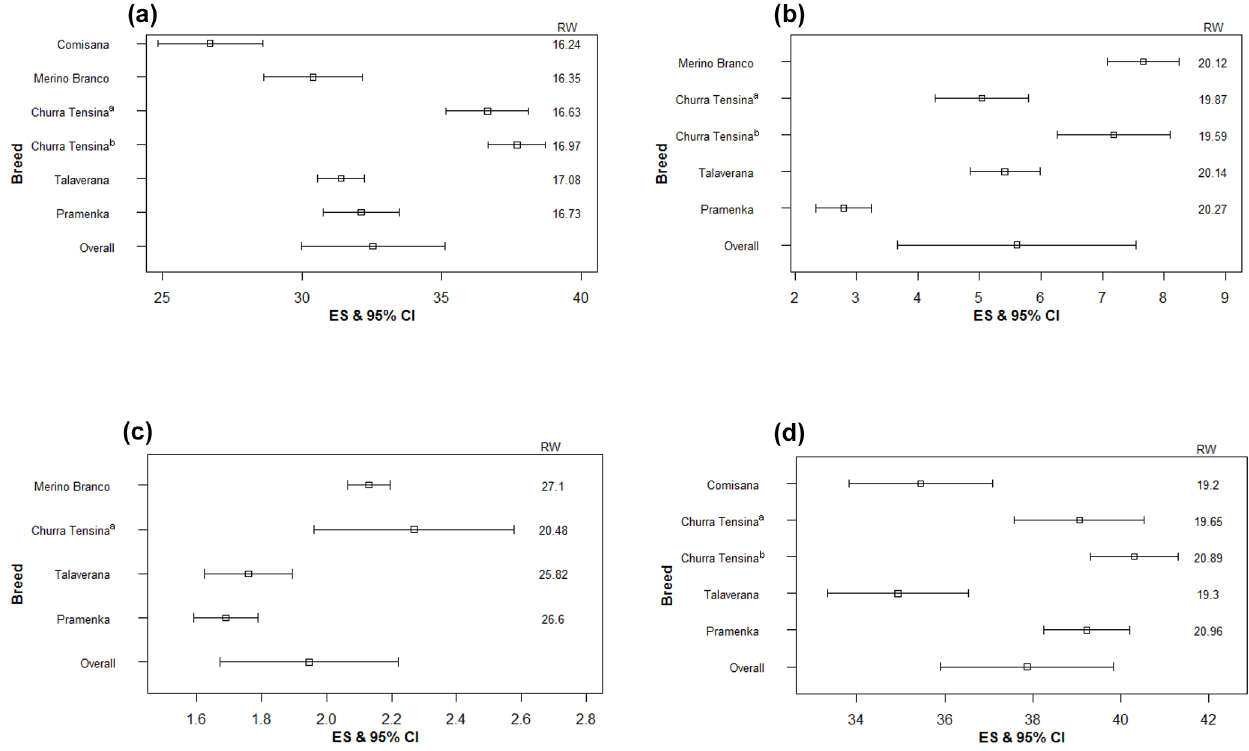
Figure 2. Meta-analysis of C18:1 (a) , C18:2 n-6 (b) , C18:3 n-3 (c) and MUFA (d) . Different superscript letters ( a,b ) indicate lambs of the same breed included in different studies; ES: effect size; CI: confidence interval; RW: relative weight of the study; Overall: overall pooled